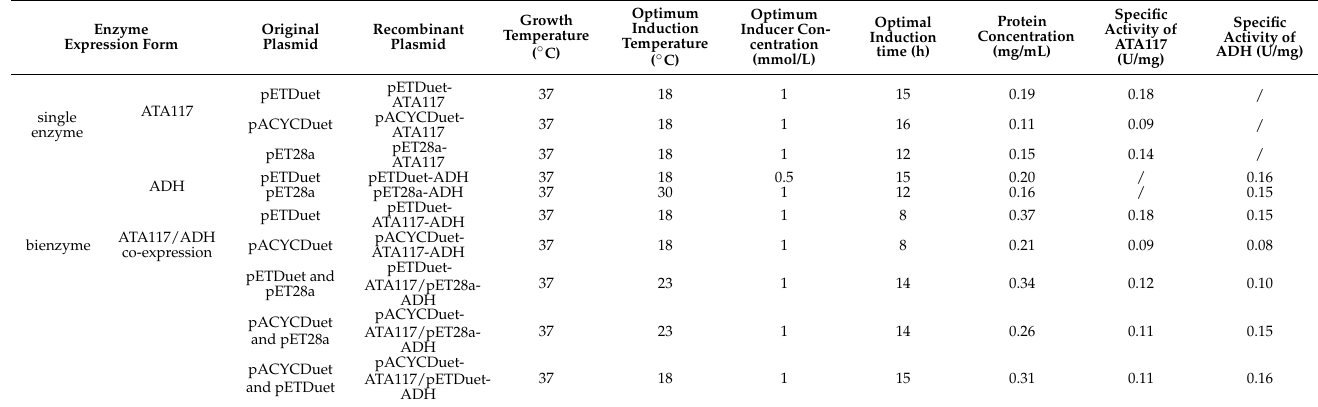
Table 2. Induced expression of the constructed recombinant plasmids. Enzyme